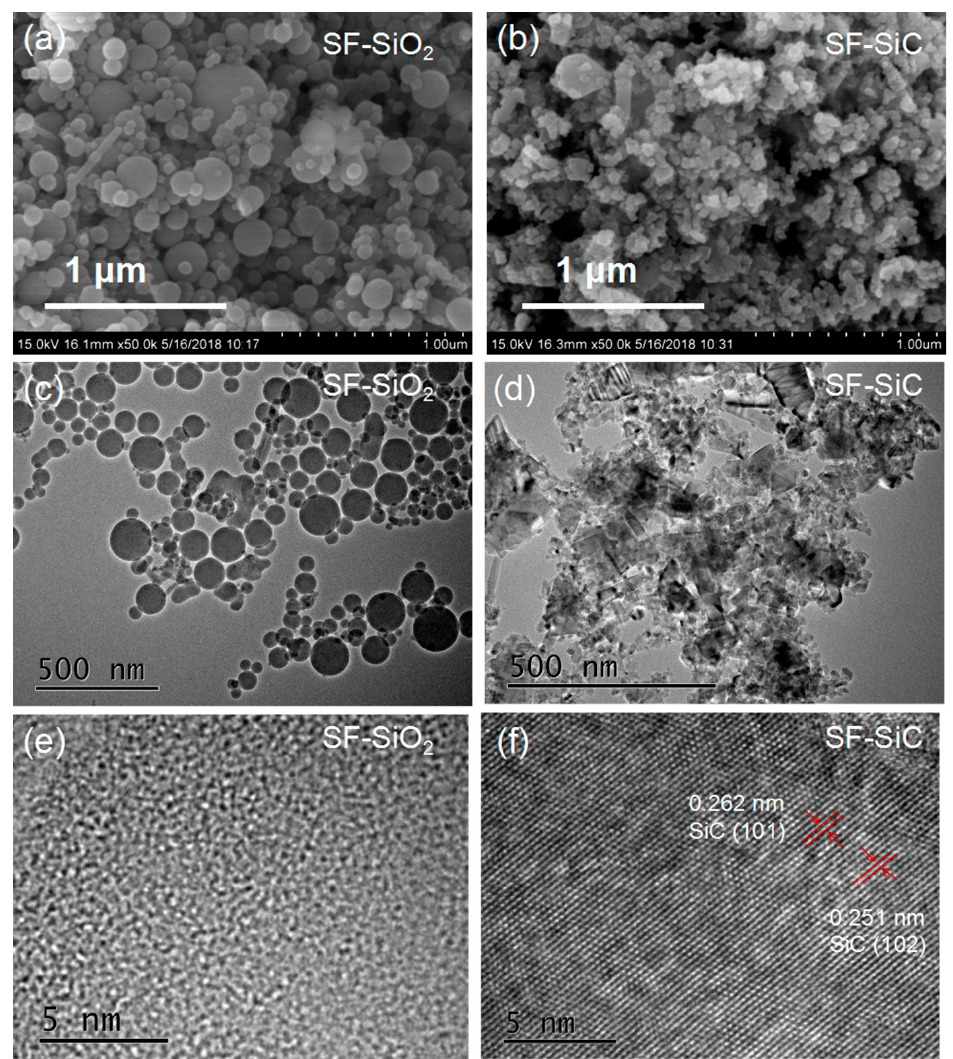
Figure 3. SEM images of the samples: ( a ) SF ‐ SiO 2 , ( b ) SF ‐ SiC; HRTEM images of samples: ( c , e ) SF ‐ SiO 2 ; ( d , f ) SF ‐ SiC.